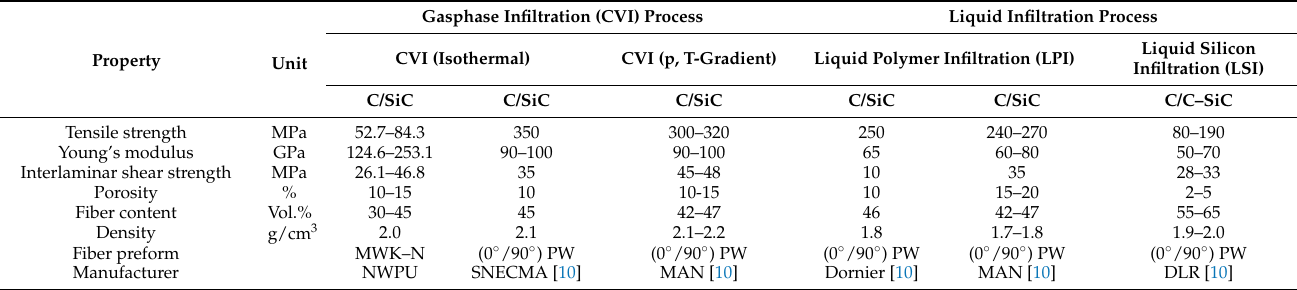
Table 4. Overview of material data for the C/SiC